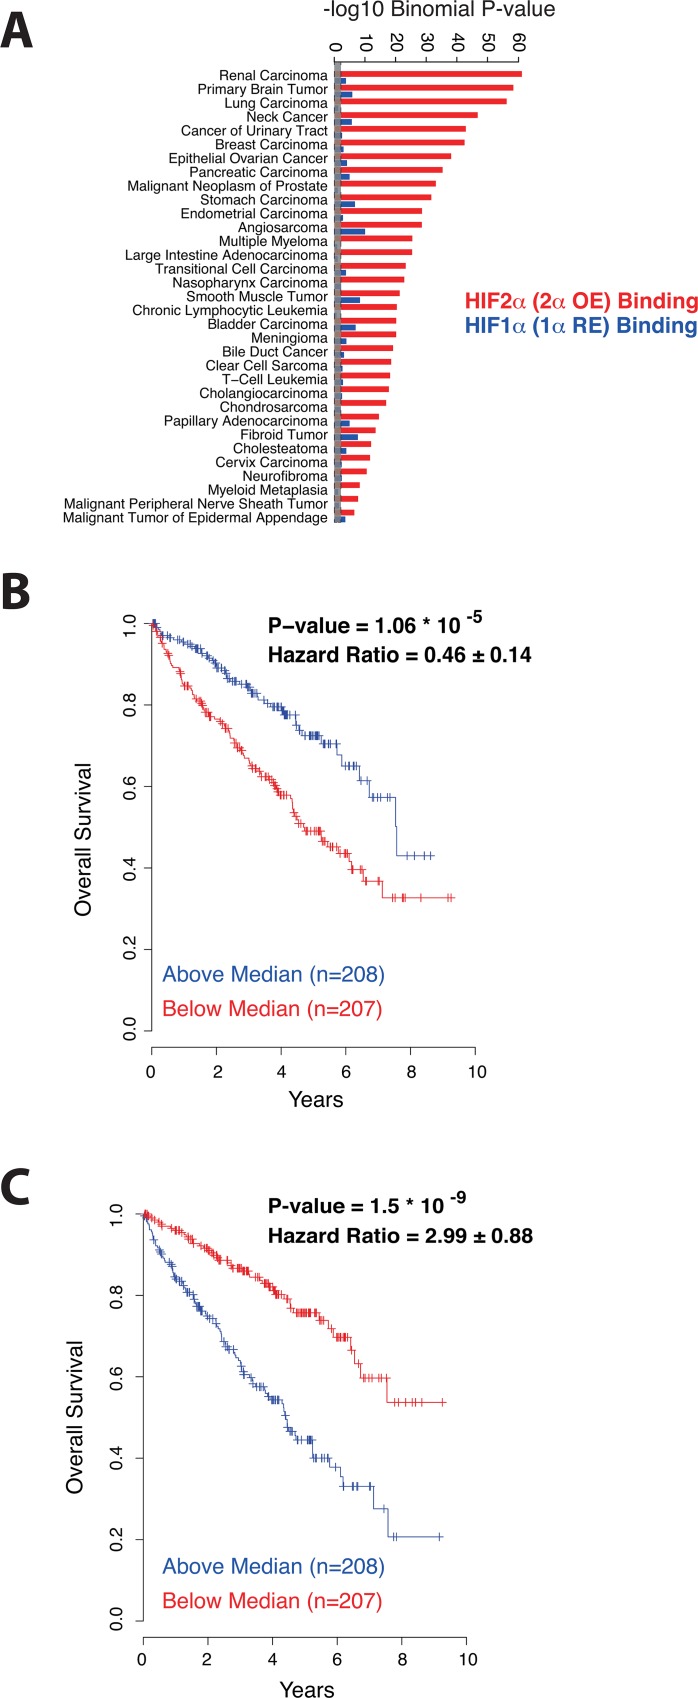
HIF-1α and HIF-2α binding genes confer opposing prognosis in kidney cancer.(A) The genes nearest to re-expressed HIF-1α (blue bars) and overexpressed HIF-2α (red bars) binding sites were defined and examined for enrichment amongst genes annotated in different cancers using the Human Disease Ontology database (http://www.disease-ontology.org).–log10 Binomial p-values are plotted for each set of HIF-binding genes in each type of cancer. Grey bar denotes p = 0.05 (-log10, 1.3) level of significance. HIF-2α nearest binding genes are consistently more significantly enriched amongst cancer-associated genes than are HIF-1α binding genes. (B) Differential HIF-1α binding genes or (C) differential HIF-2α binding genes were filtered for significant associations with overall survival and used to generate a weighted gene predictor of prognosis for each set of genes. Patients were then divided into those with above or below median values for each gene predictor and subjected to Kaplan-Meier survival analysis. The Cox proportional hazard model indicated a significant protective effect for patients with above median gene predictor values based on the HIF-1α binding genes. Conversely, patients with above median values for the HIF-2α binding gene predictor had a significantly worse prognosis.